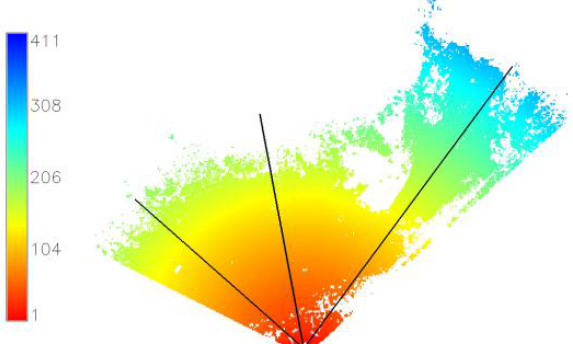
Figure 3. Range (meters) color scale of study site. Black lines represent transects used for quality